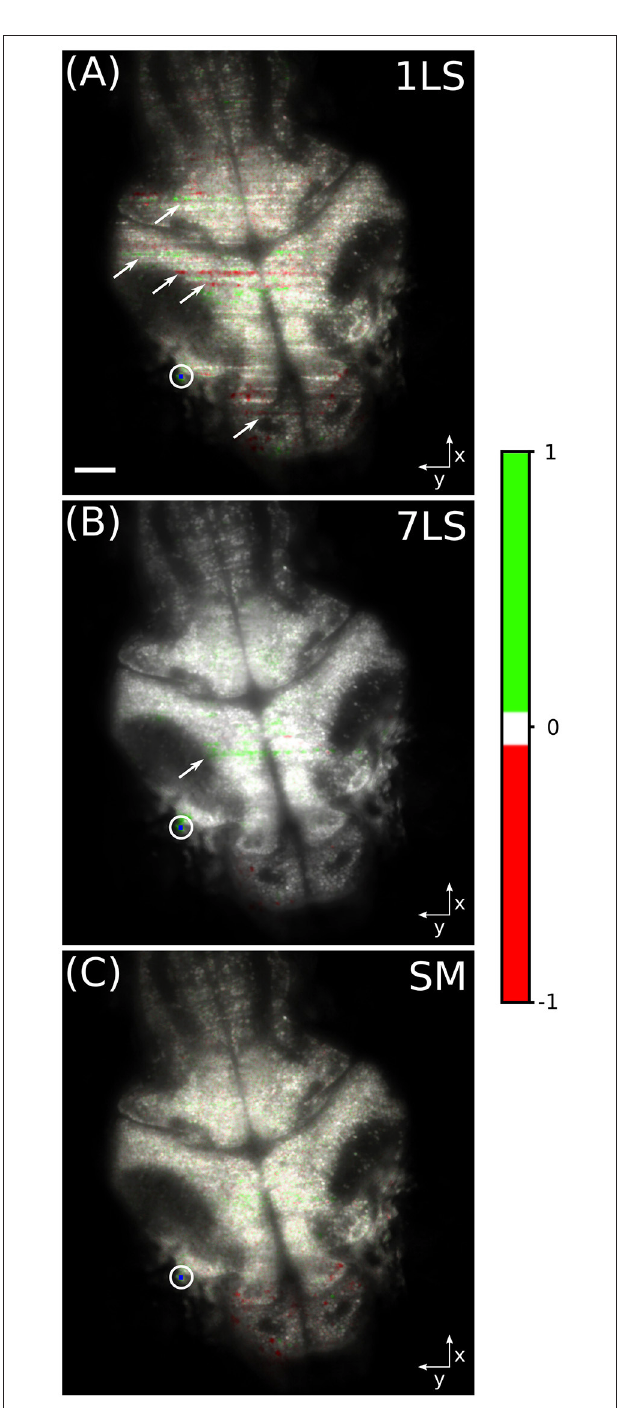
FIGURE 4 | HSV images of a fluorescent zebrafish larva brain, for a single static (A) , seven static (B) , and a dynamically swept (C) light-sheet illumination. The average fluorescence intensity is mapped on the value channel, while the saturation channel and the hue channel are a function of the Pearson correlation coefficient, as detailed by the color-bar. The temporal correlation was computed between the pixel visualized in blue inside the white circle and every other pixel in the dataset. Striping artifacts, like the ones indicated by arrows, can be mistaken for biological-like activation events in functional live-studies of neural activity. White scale bar of 50 µ